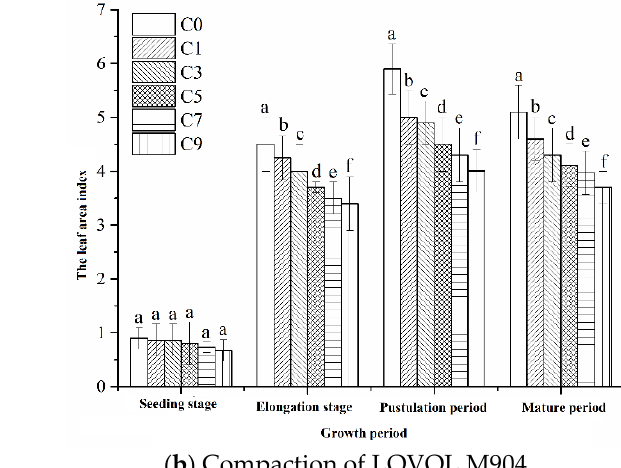
Figure 7. Effects of soil compaction on leaf area index (LAI) of maize during the critical growth period. Different lowercase letters indicate significant differences among treatments ( p < 0.05).